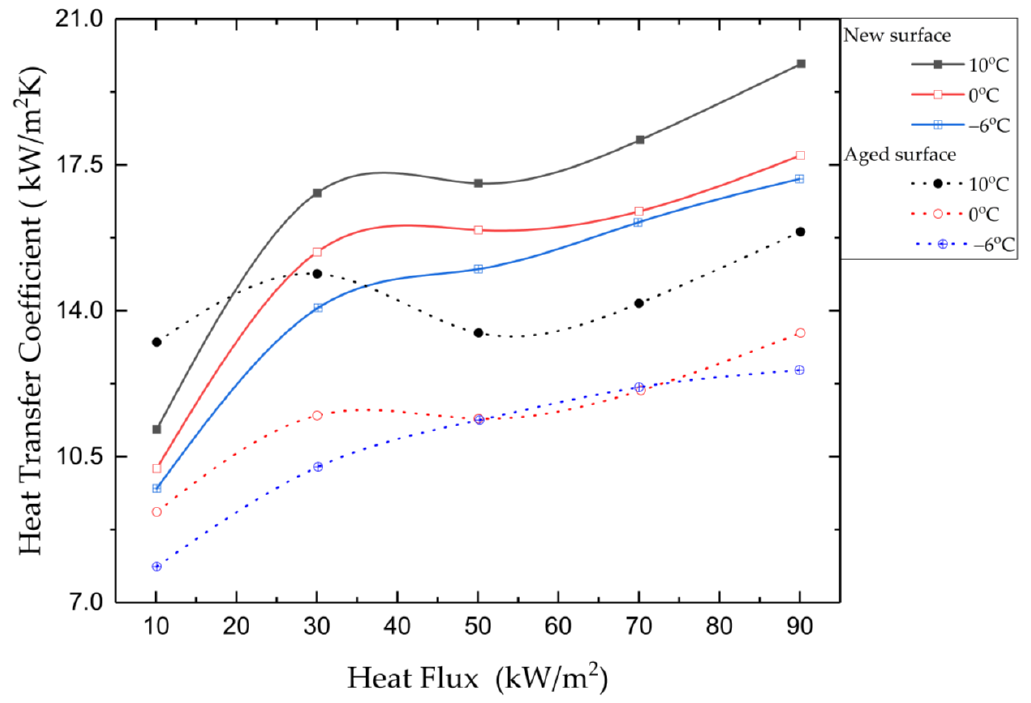
Figure 5. HTCs for new and aged surfaces versus heat flux curves at various saturation tempera- tures [21].